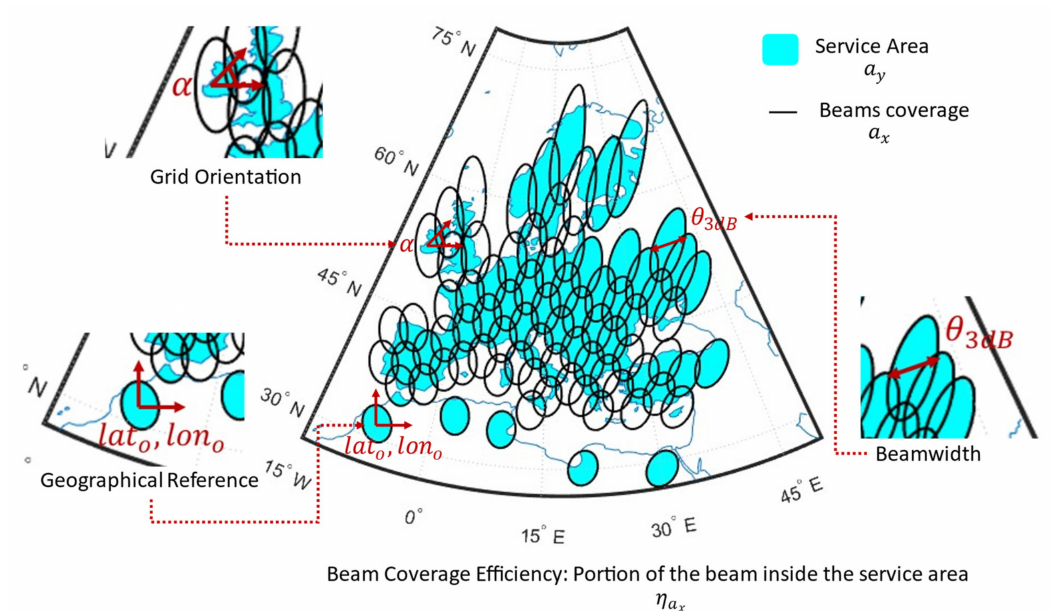
Figure 3. System parameters that influence the design of the multibeam coverage. a y is the required service area (in square kilometers). The pair of lat o and lon o are the geographical position references. The θ 3dB parameter is the half-power beamwidth. The inclination angle α represents the beam’s grid